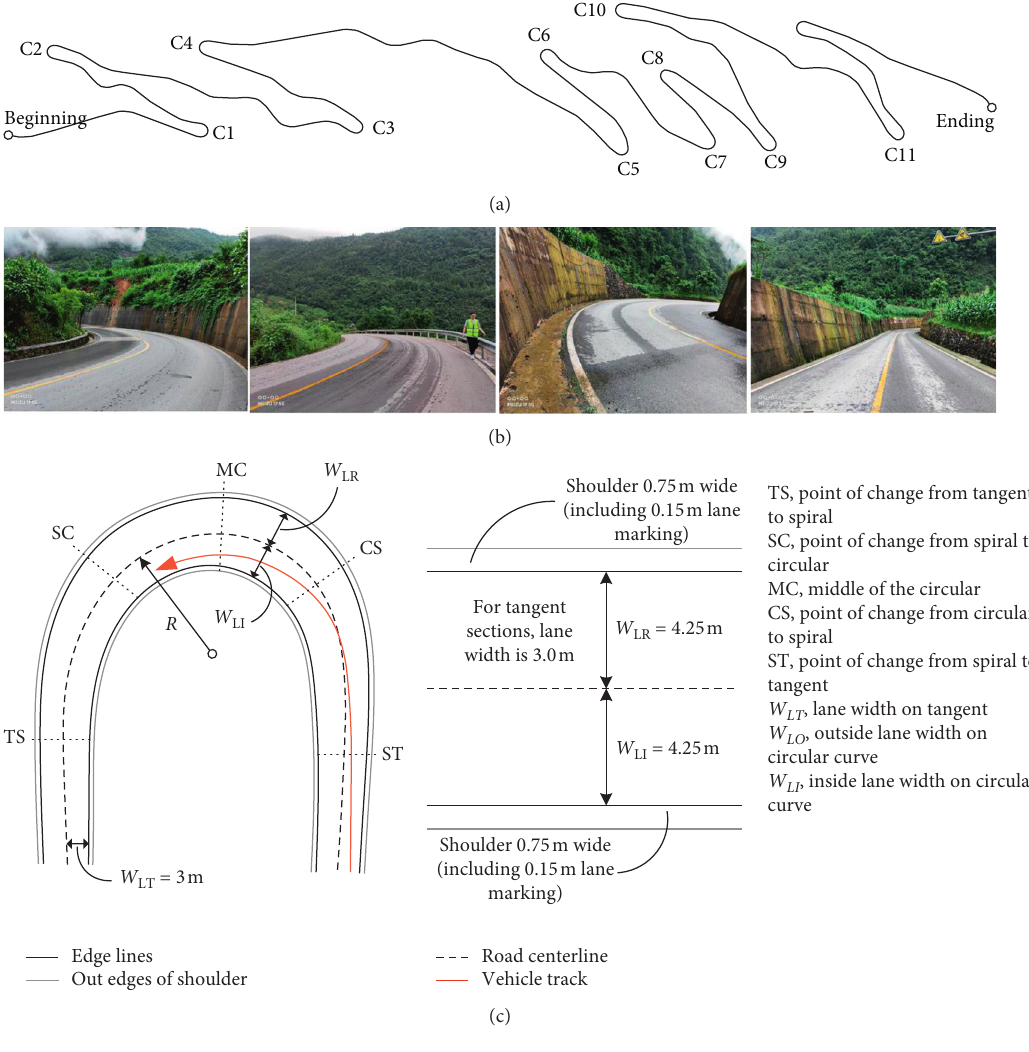
Figure 2: The test road. (a) Test road section. (b) Pavement, lane marking, and roadside environment. (c) Geometry parameters of hairpin curves. Table 1: Geometric parameters of the hairpin